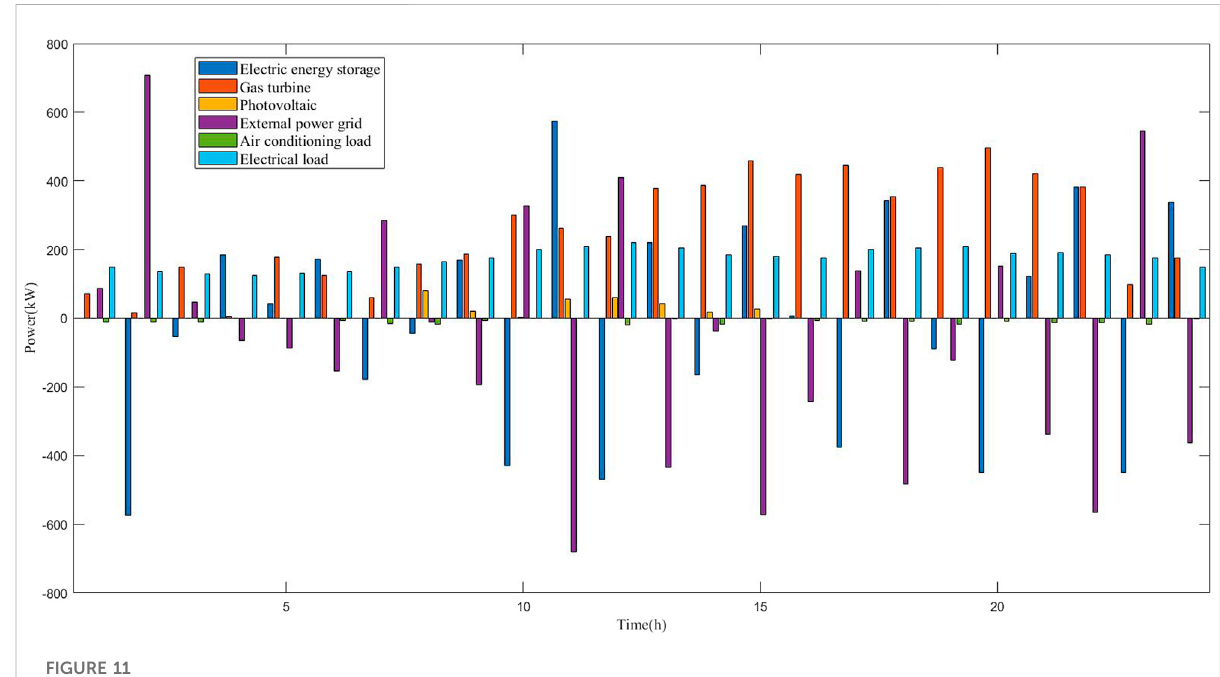
FIGURE 11 Optimization results of power load under Case 2.